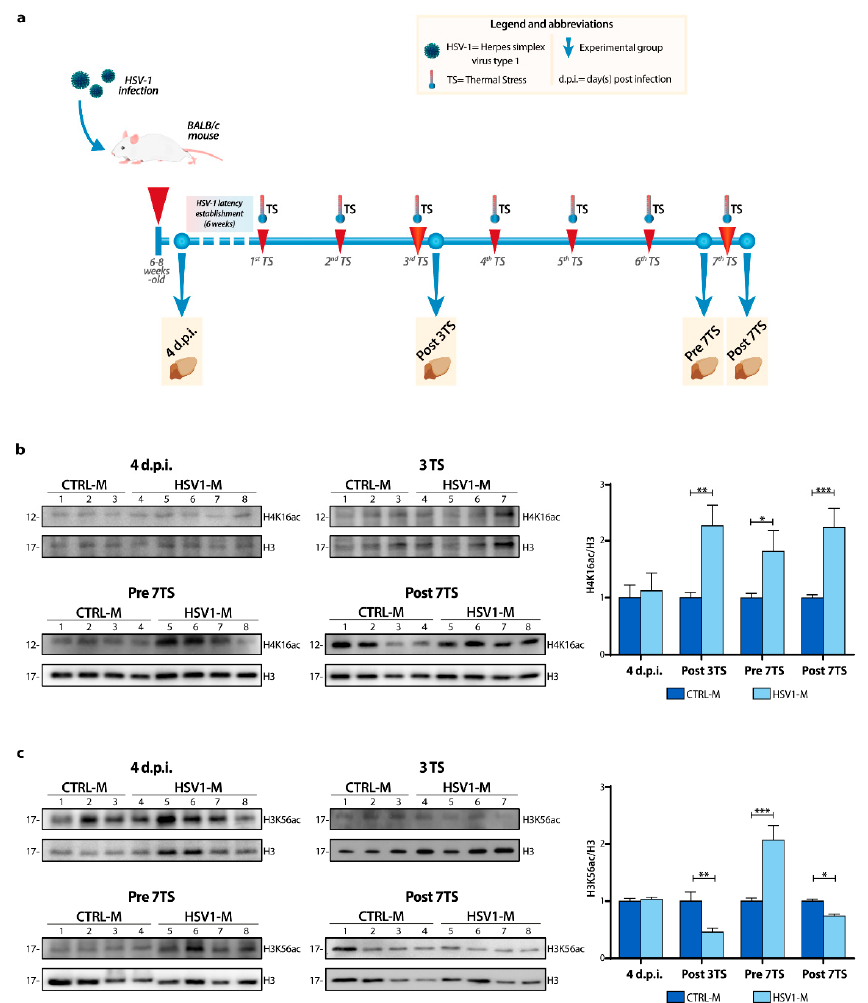
Figure 3. Schematic representation of the recurrent HSV-1 infection and modulation of histone acetylation levels in vivo. ( a ) Timeline showing HSV-1 infection, TS-induced virus reactivations, and chosen experimental time-points over the mouse life. The HSV-1 inoculation (primary infection) was performed by snout abrasion (first red arrow). TS induces viral reactivations are indicated by red arrows. The dashed line indicates the establishment of the latent infection. Mice were sacrificed and analyzed at the following time points (blue dots) indicated by the yellow boxes: 4 d.p.i., following the 3rd (at 6 months of age, Post 3TS) and the 7th TS (13 months of age, Post 7TS) or 24 h just before the 7th TS (Pre 7TS). Representative WBs showing H4K16 ( b ) and H3K56 ( c ) acetylation levels in the whole lysate from the cortices of 4 d.p.i., Post 3TS, Pre and Post 7TS mice. Densitometric analyses were performed with ImageLab software and normalized to H3 or tubulin expression. The values represent the normalized fold-changes in protein levels from HSV1-M with respect to CTRL-M. Data are mean ± SEM. * p < 0.05; ** p < 0.01; *** p < 0.001. Statistical significance was calculated by multiple t-test and determined using the Sidak–Bonferroni method, with alpha = 0.05. Firstly, we checked whether multiple cycles of viral latency and reactivation as well as primary virus infection could affect the H4K16 and H3K56 acetylation patterns in mouse brains by WB analysis of cortical homogenates from Post 3TS, Pre 7TS, Post 7TS mice, and 4 d.p.i. mice. We found that TS-induced viral replications caused a significant